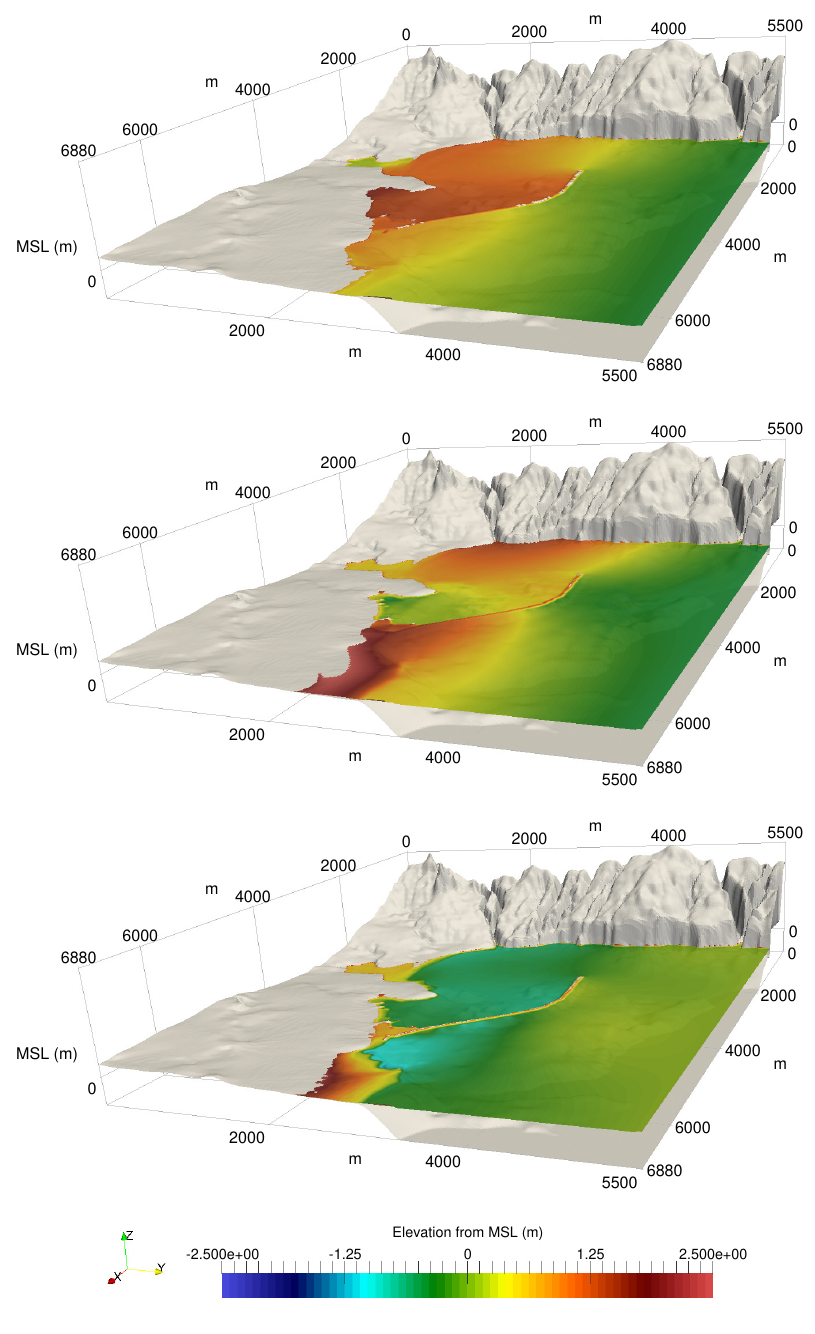
Figure 16. Case 4: visualization of tsunami inundation using the CU scheme at 9.03, 9.53, and 11